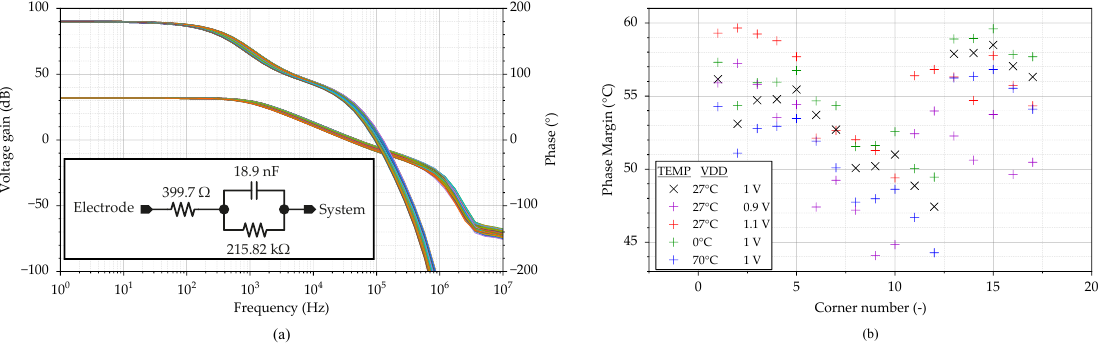
Figure 12. Stability analysis of the active ground loop: ( a ) gain and phase waveform and ( b ) values of phase margin over PVT